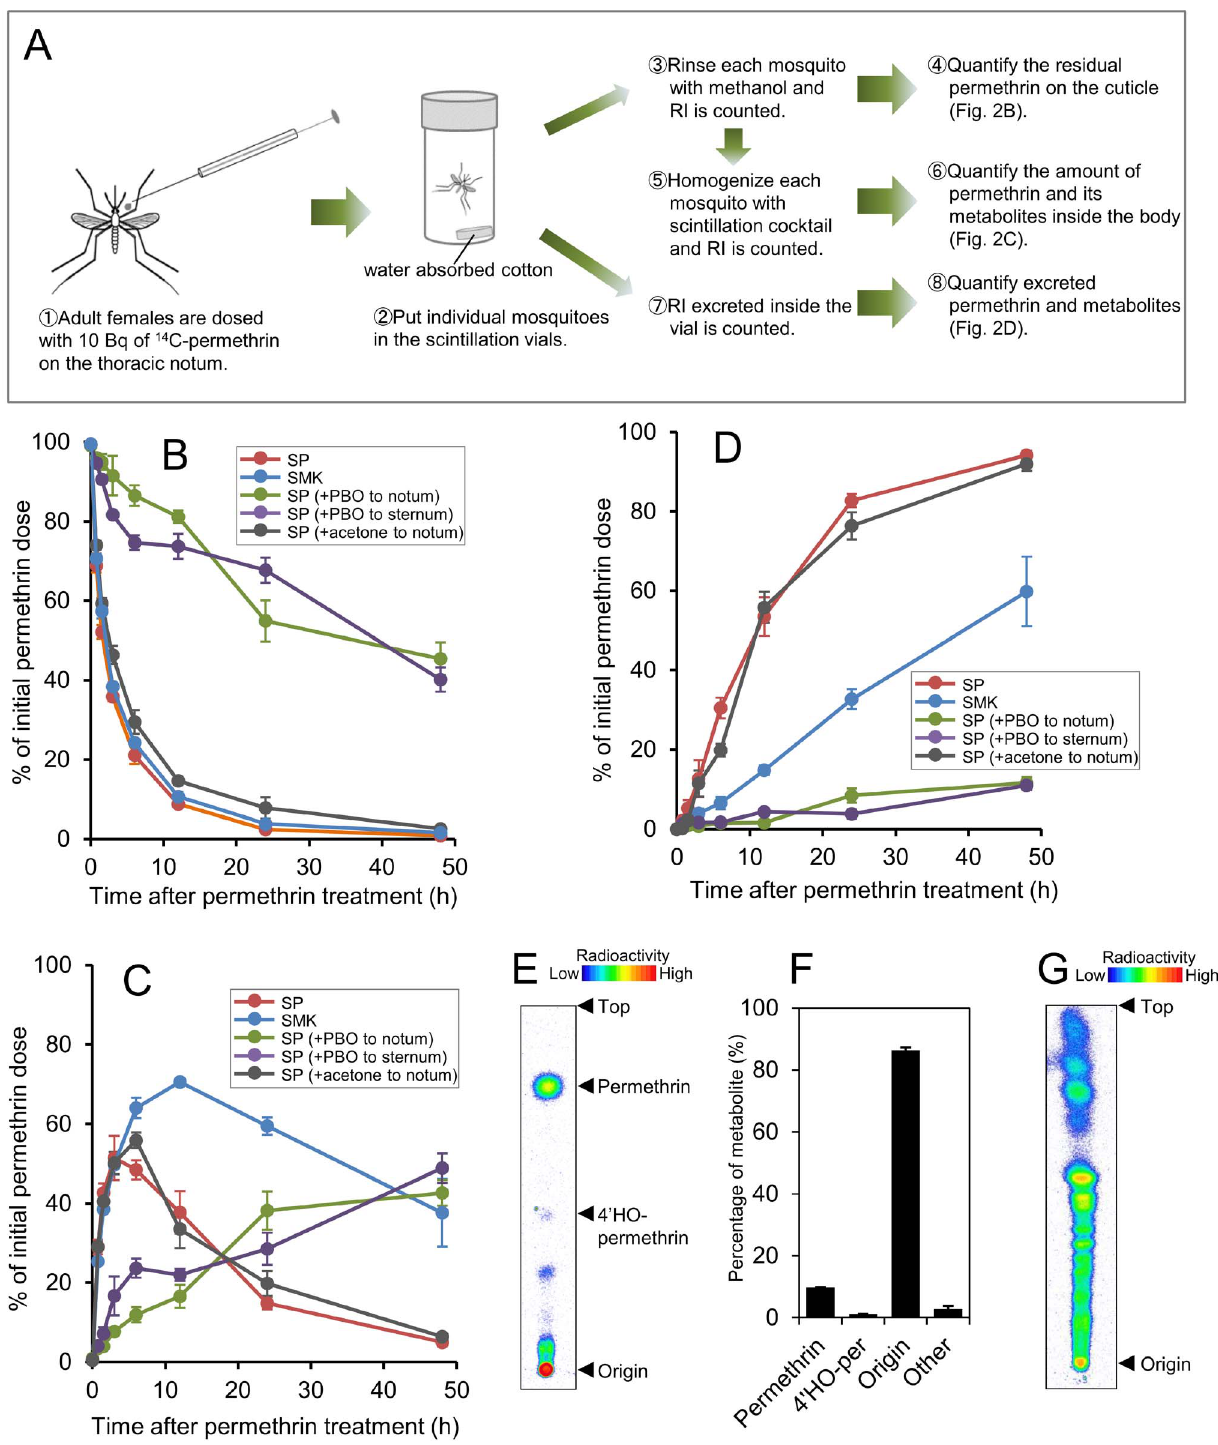
Figure 2. Invivo distribution of [ 14 C]-permethrin topically applied to SP and SMK strains of Aedesaegypti . (A) Schematic of the procedure of in vivo assay. (B) Percentage of the applied radiolabel recovered in the external rinse. [ 14 C]-Permethrin (600 dpm; 0.88 ng) was applied to the thoracic notum. PBO (5 m g) was also applied to the thoracic notum or thoracic sternum 1 h prior to permethrin application to observe its effect on permethrin penetration. Acetone was also applied 1 h prior to permethrin application to confirm whether the solvent had any side effects. Values are expressed as the means ( 6 SE) for four mosquitoes. (C) Percentage of radioactivity detected in the mosquitoes. (D) Percentage of radioactivity excreted in the vials. (E) Thin-layer chromatogram of the compounds excreted by females of SP strain. Developing solvents: toluene/ethyl acetate (6:1). The presence of 4 9 -HO-permethrin was determined by co-chromatography with an authenticated chemical. (F) Percentage of permethrin and its metabolites excreted by females of SP strain. Values represent the average and bars represent the SE of the mean (n = 3). (G) Re-chromatography of the high-polar compounds stuck around origin. Developing solvents: chloroform/methanol/water (65:25:4). doi:10.1371/journal.pntd.0002948.g002 PLOS Neglected Tropical Diseases |